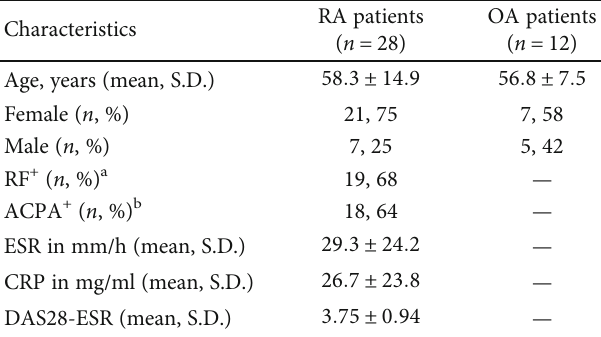
ACPA: anticyclic citrullinated peptide antibodies; CRP: C-reactive protein; DAS: disease activity score; ESR: erythrocyte sedimentation rate; OA: